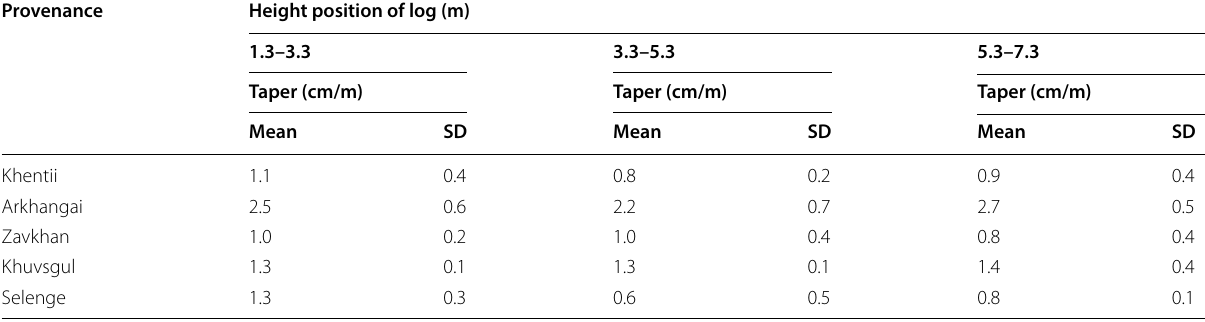
Table 9 Taper values of logs at three height positions